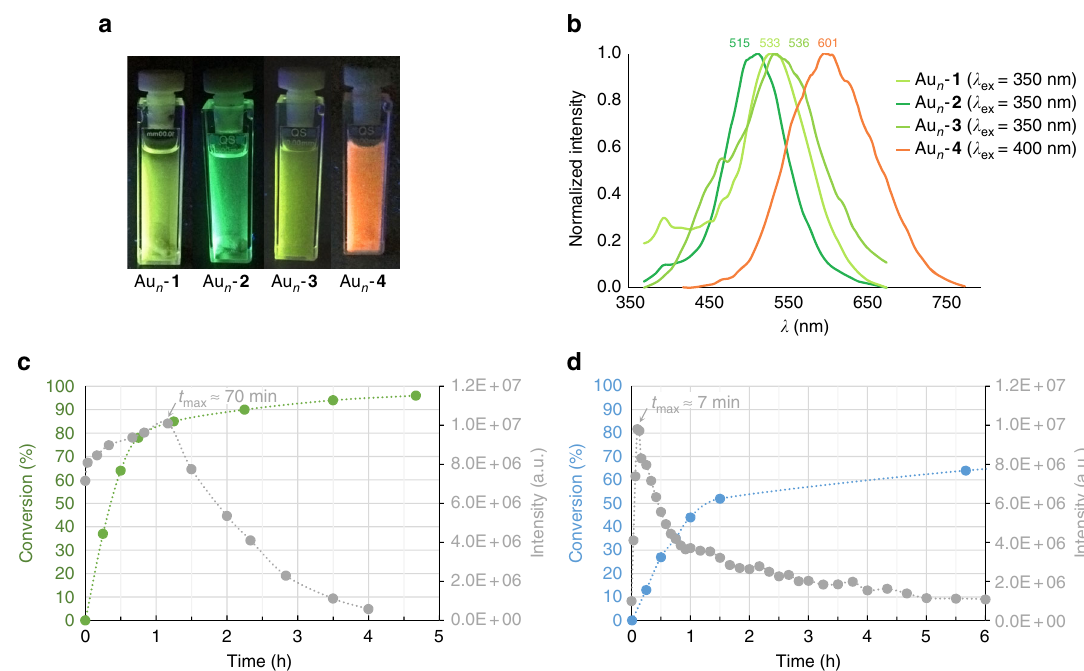
Fig. 3 Emissive properties of Au n -alkynes complexes. a Pictures of reaction mixtures prepared from alkynes ( 1 – 4 ) and AuCl ( I ) as a precatalyst, obtained under UV lamp irradiation (365 nm). The species formed with 1-hexyne ( 1 ), 1-dodecyne ( 2 ), and benzylacetylene ( 3 ) emit at higher energy ( green-yellow) than phenylacetylene ( 4 ) (orange), indicating the formation of smaller size Au subnanoclusters with alkynes 1-3. b Emission spectra acquired for these same mixtures under irradiation at 350 – 400 nm. c , d Time-resolved emission intensity (in gray) vs. alkyne conversion in the catalytic hydration of 1- dodecyne ( 2 , in green) and phenylacetylene ( 4 , in blue). A longer high emission intensity (~70 min) was measured for ( 2 ) compared to ( 4 ) (~7 min). Conversion rapidly increases during the high-intensity emission intervals, and decreases when emission decays. All experiments were performed using 4% mol AuCl ( I ) as a precatalyst in methanol at 65